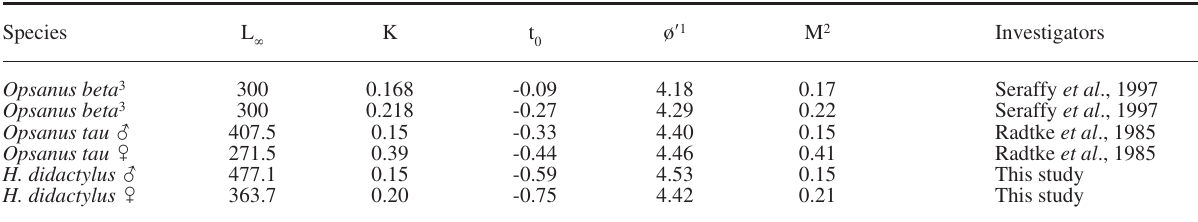
Table 5. – Comparisons of estimates of the von Bertalanffy growth parameters, ø ʹ value and natural mortality rates reported by various authors